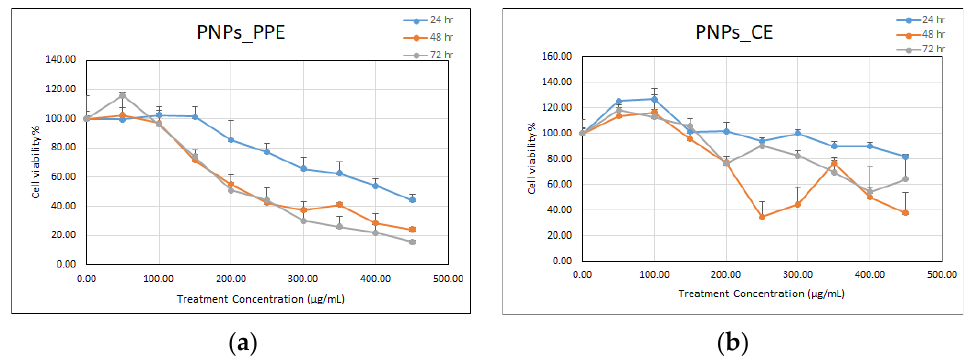
Figure 8. Percentage of cell viability of Vero E6 cells according to serial dilutions treatment of nHAP_PPE ( a ), and nHAP_CE ( b ) at different sampling times: 24 h, 48 h, and 72 h.